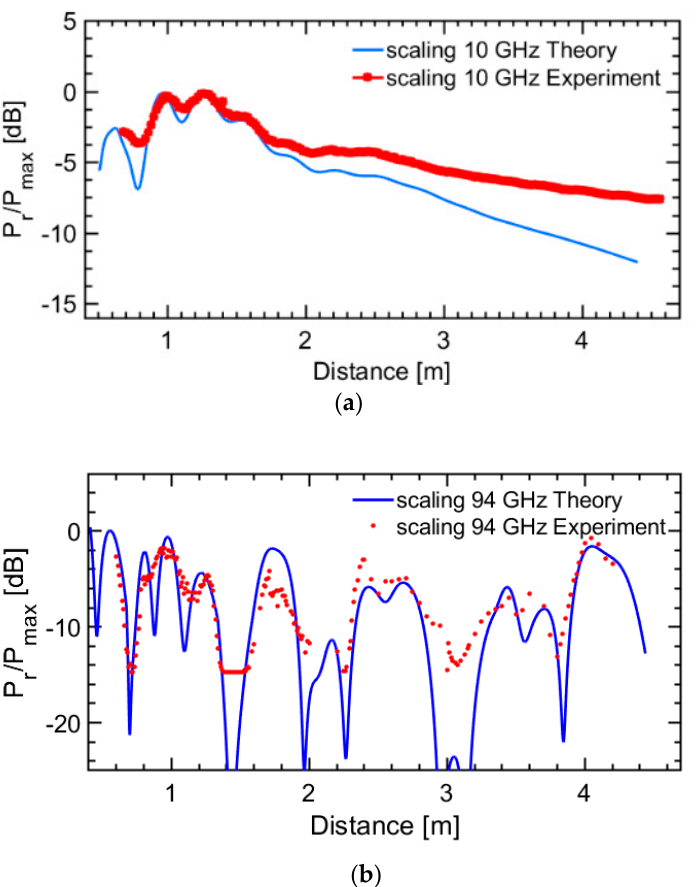
Figure 7. Normalized results of the scale model experiments and simulation as a function of dis- tance for frequencies of ( a ) SHF 10 GHz, and ( b ) MMW 94